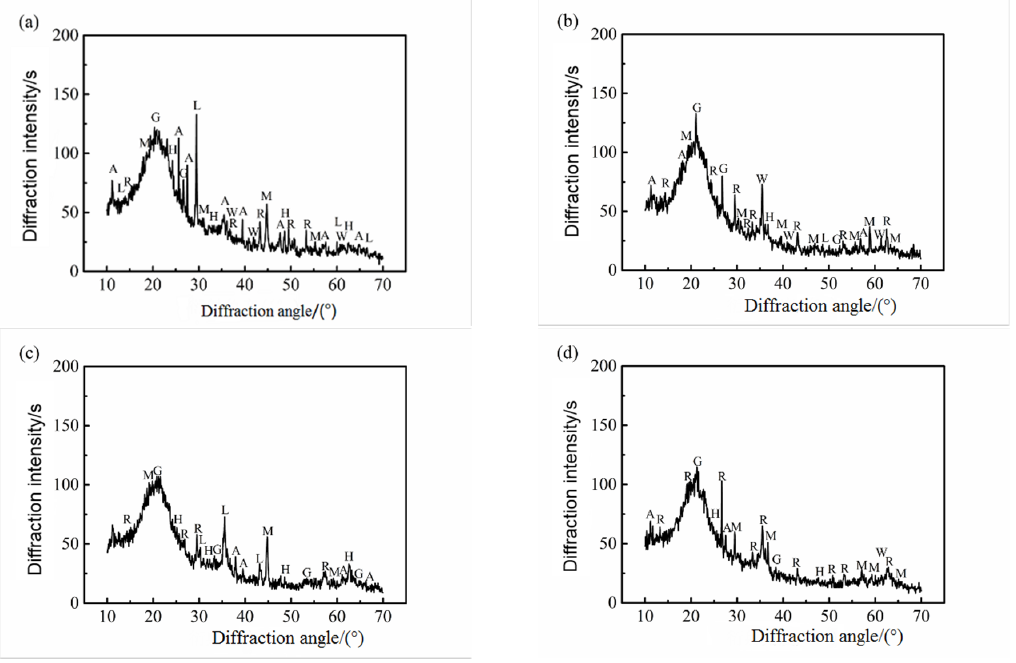
Figure 5. XRD patterns of rust sample of steel bar in seawater sea-sand concrete; ( a ) Inner rust layer of A1, ( b ) Outer rust layer of A1, ( c ) Inner rust layer of A2, ( d ) Outer rust layer of A2.